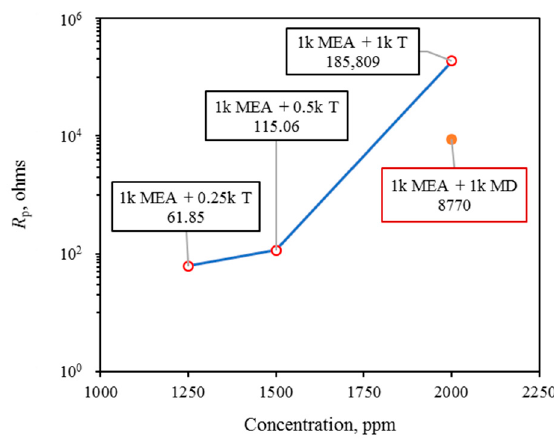
Figure 9. Effect of co-addition of corrosion inhibitors on the polarization resistance of the passive film formed at 0 V(SCE) in deaerated [tap water + 1 k ppm monoethanolamine (MEA) + x ppm tungstate (T)] at 30 °C (This figure included 1 k ppm monoethanolamine (MEA) + 1 k ppm molybdate (MD) [32]).